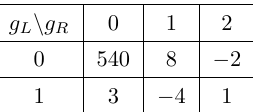
) = (0 , d ) in the B , d E E